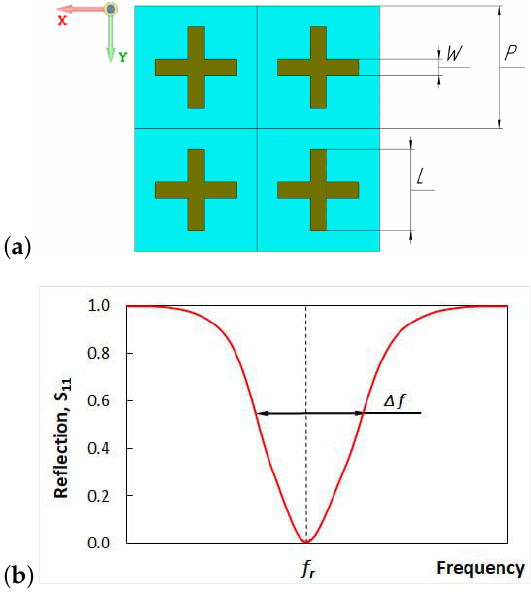
Figure 1. ( a ) Geometric parameters of a periodic frequency-selective surface: P is a structure period, L is a cross length, and W is a cross width. ( b ) Typical view of reflection amplitude spectrum: f r is a resonance frequency, ∆ f is a bandwidth, that can be found as a bandwidth corresponding to the semiamplitude.